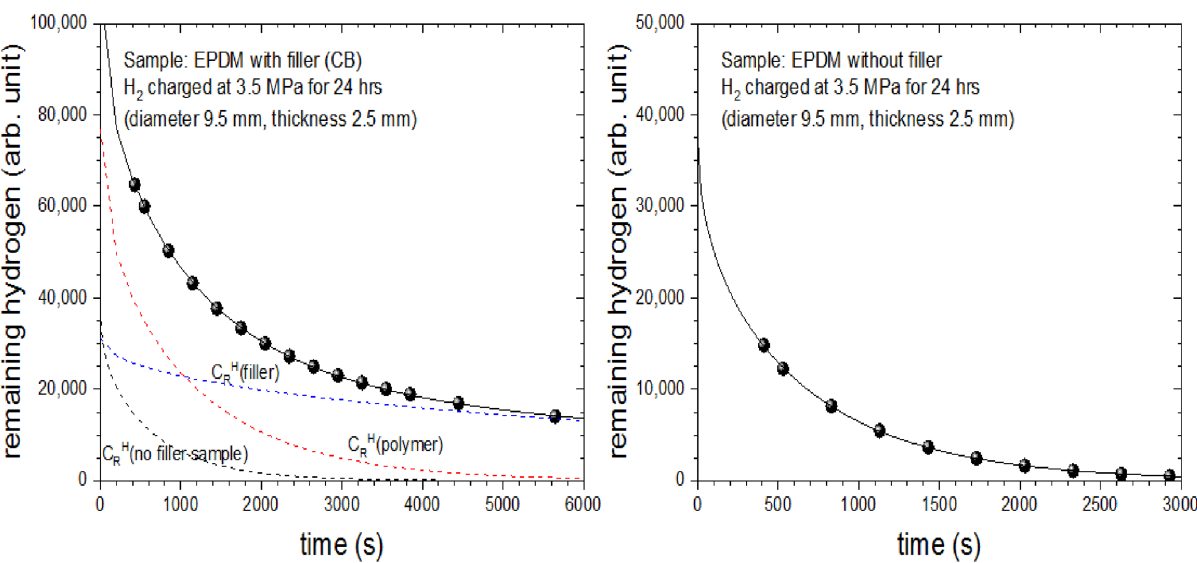
Figure 8. The different diffusion behaviors of residual hydrogen contents over elapsed time in the EPDM sample with CB filler (left) and without CB filler